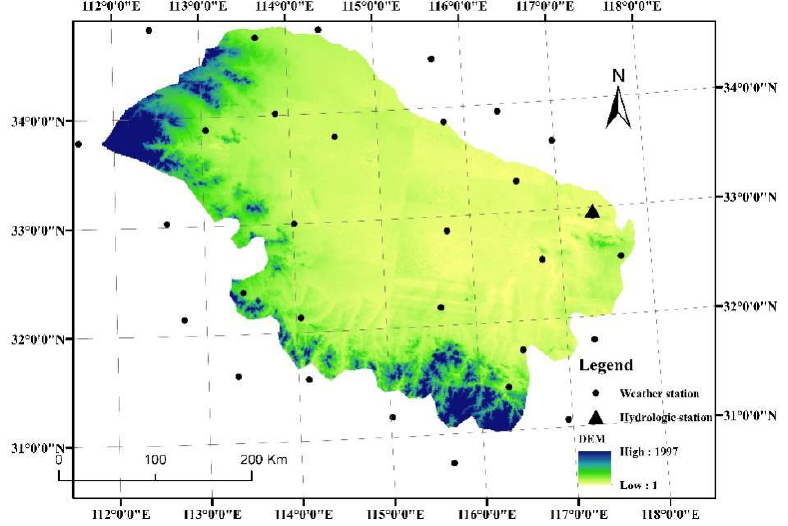
Figure 1. Location of the study area.